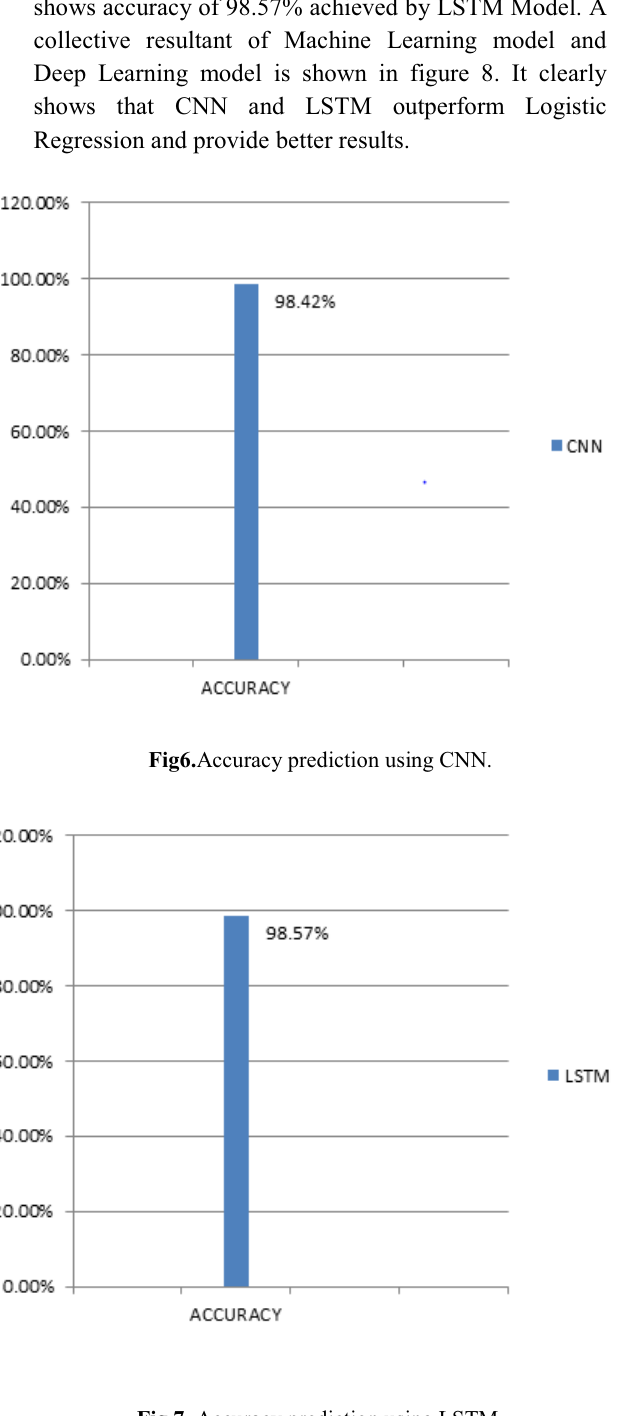
Fig.7 . Accuracy prediction using LSTM.